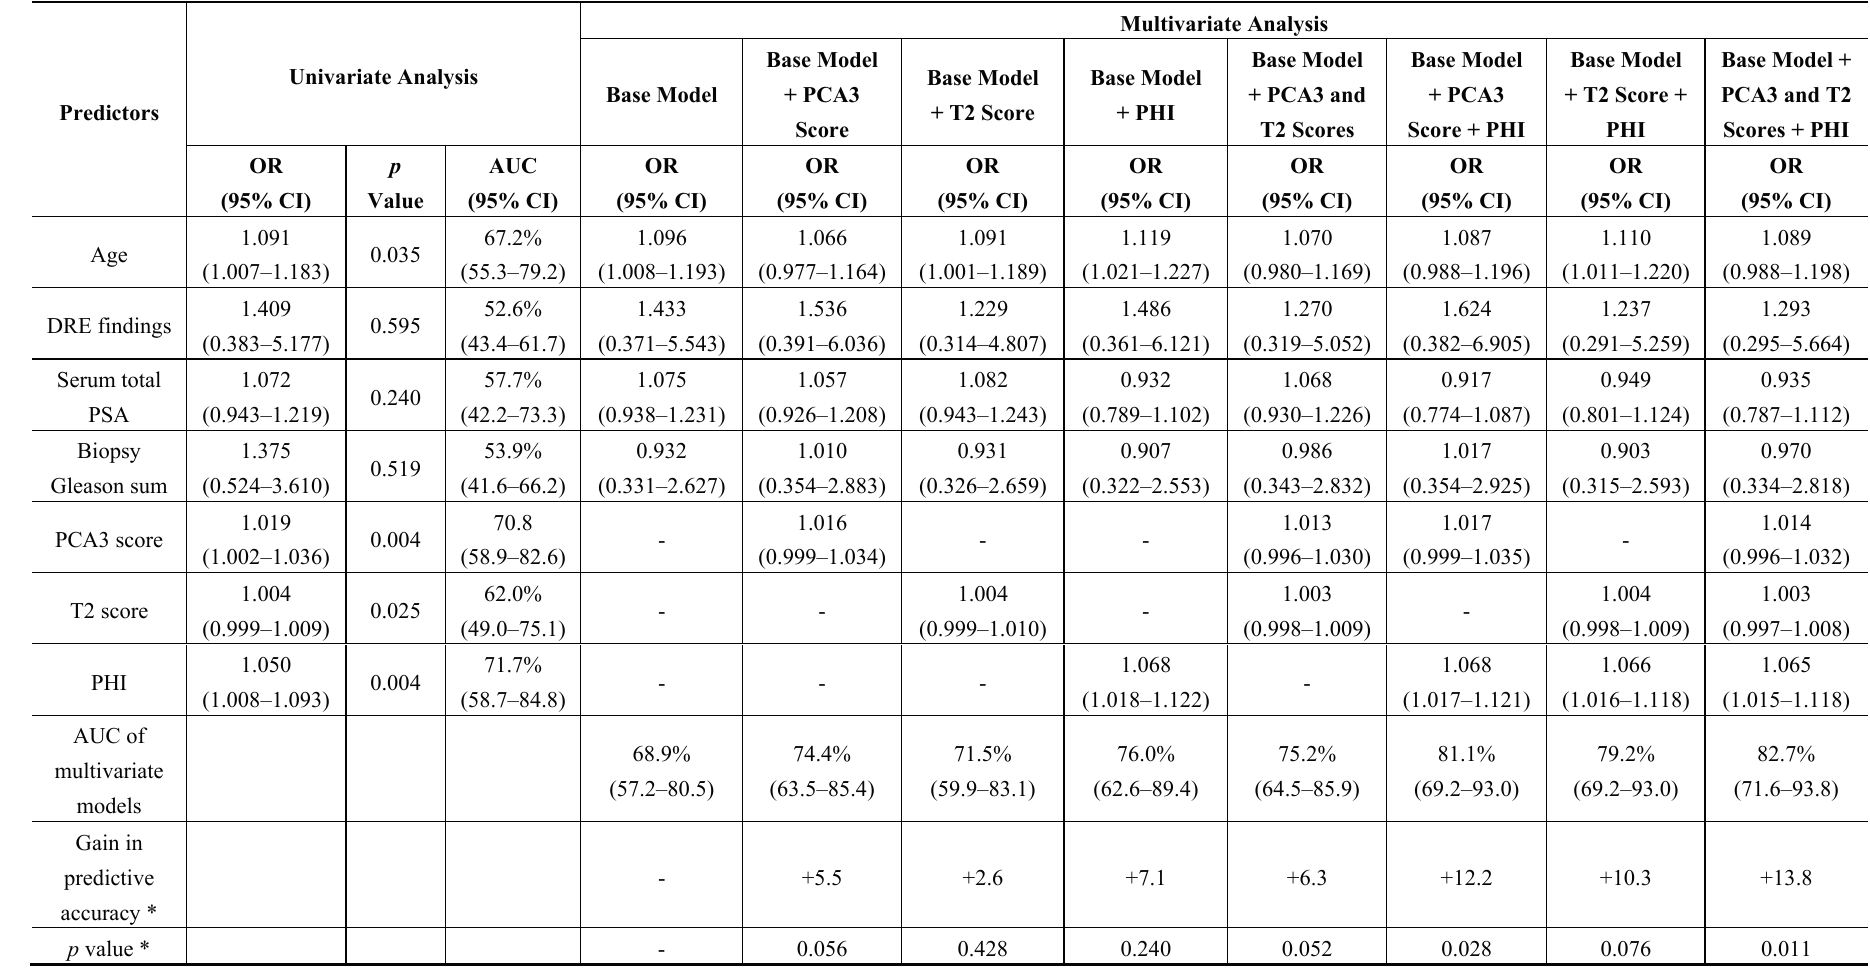
Table 5. Prediction of tumor volume ≥ 0.5 mL at